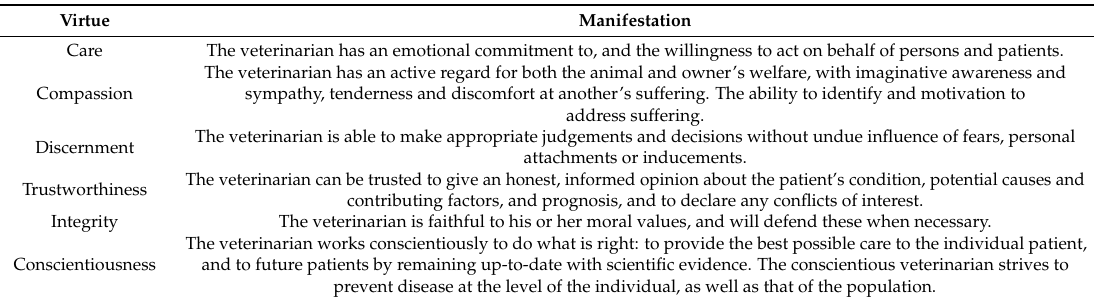
Table 2. Beauchamp and Childress’ focal virtues for medical professionals, and how these may manifest in the veterinarian presented with the brachycephalic